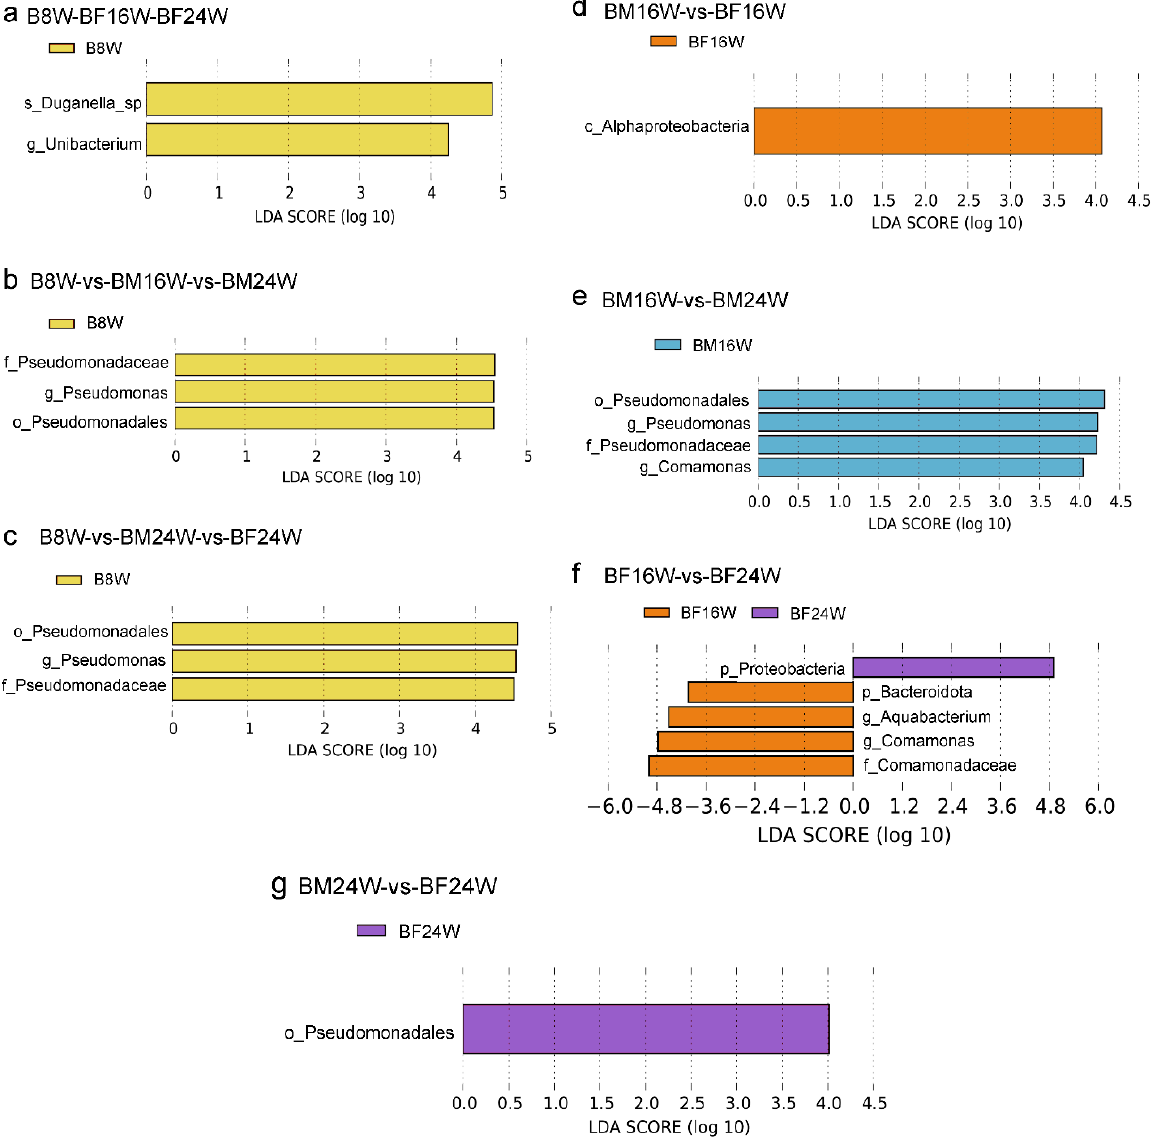
Figure 4. LEfSe analysis of the relative abundances of gut microbiota in Siamese fighting fish across age and gender groups. Adult groups of the same gender were compared to the young group (B8W). ( a – g ) Differentially abundant taxa across groups with LDA score > 4.0. LEfSe analysis showed no bacteria taxa enriched in B8W, BM16W, or BF16F. B8W, 8-week-old Siamese fighting fish; BM16W, 16-week-old male Siamese fighting fish; BF16W, 16-week-old female Siamese fighting fish; BM24W, 24-week-old male Siamese fighting fish; BF24W, 24-week-old female Siamese fighting